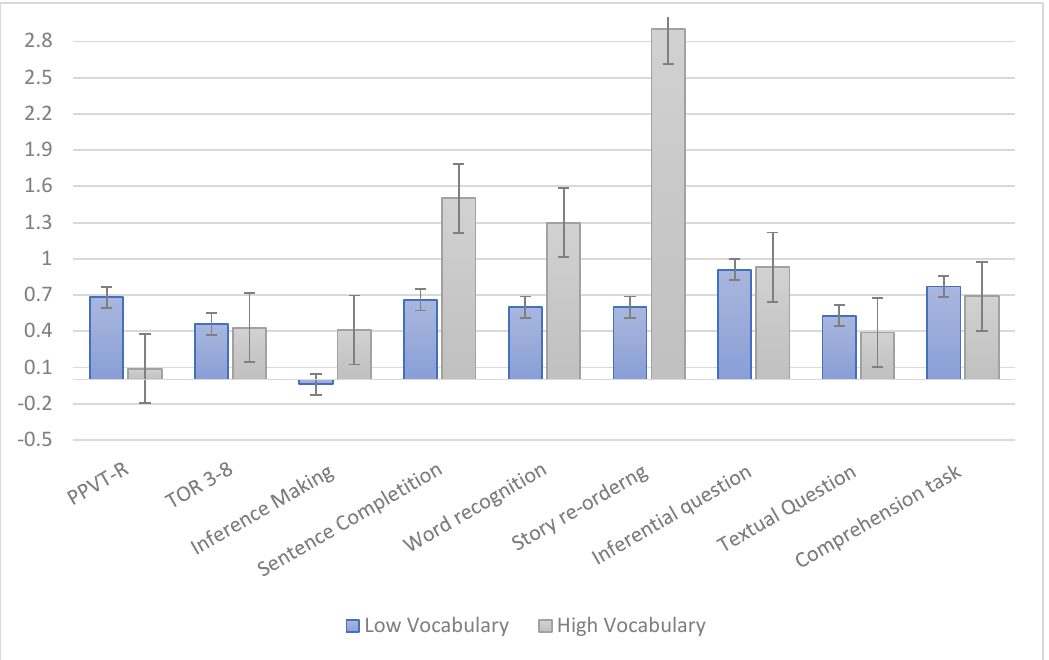
Figure 2. Standardized training gains for differences between pre-test and post-test for two groups (high and low vocabulary).